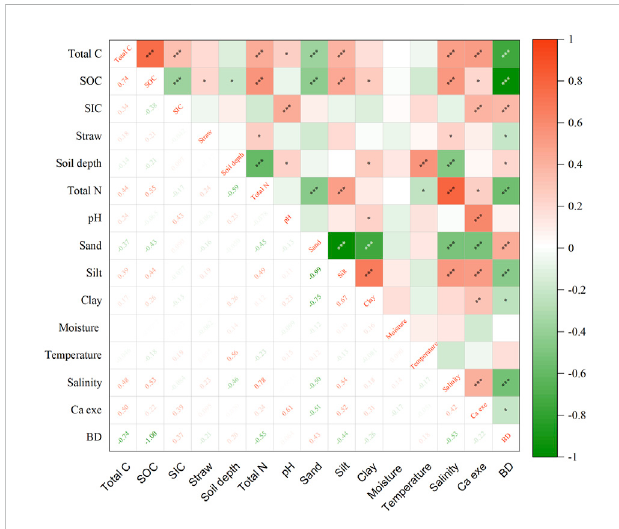
FIGURE 5 Pairwisecomparisonsofenvironmentalfactors,SOCstock,andSIC stock; Color gradients represent Pearson ’ s correlation coef fi cients. *, **, and *** denote signi fi cant correlation coef fi cient at p < 0.05, p < 0.01, and p < 0.001,